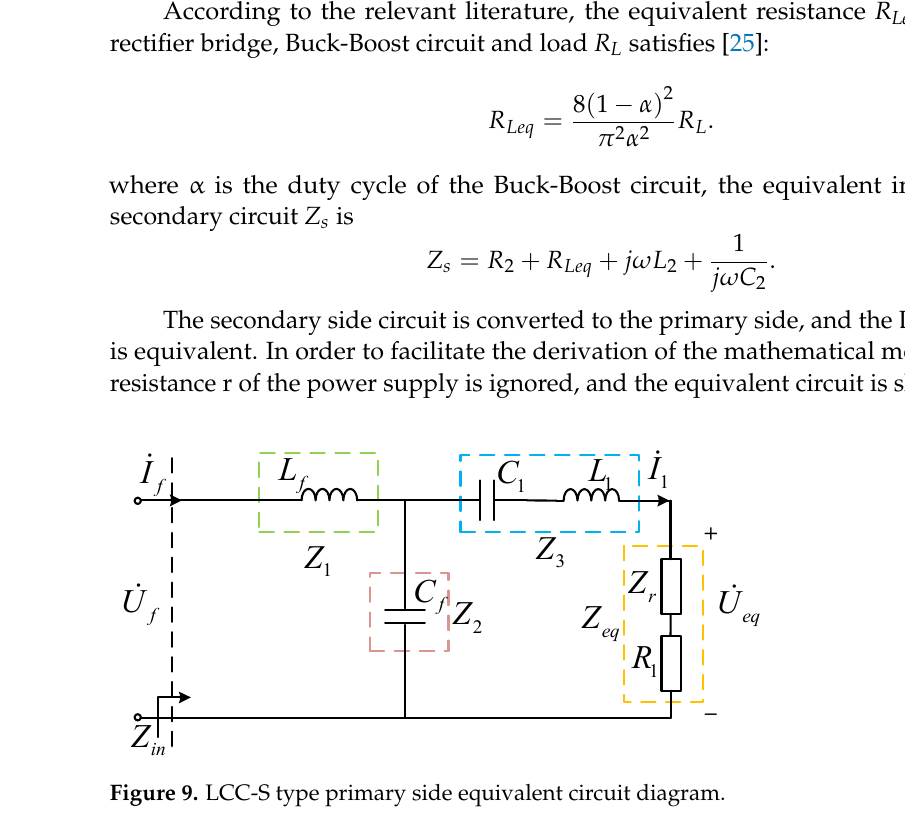
Battery dc E r Figure 8. The wireless power transfer system with LCC-S compensation. 3.2. Mathematical Modeling of LCC-S System